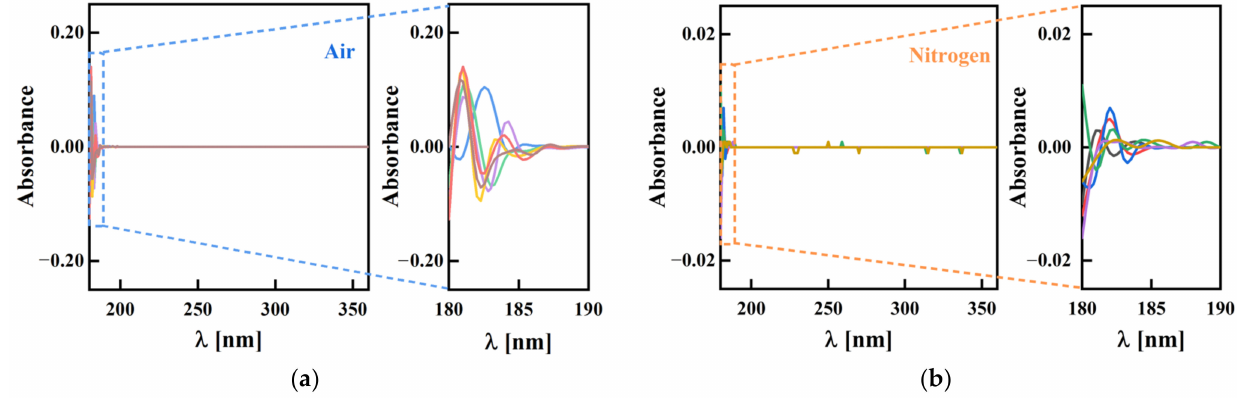
Figure 4. Results of 6 baseline straightness tests under ( a ) air and nitrogen ( b )